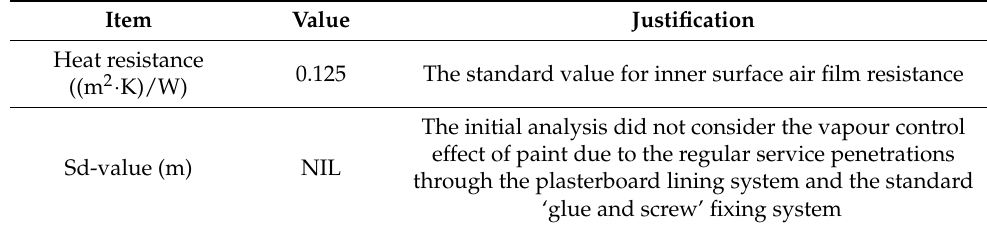
Table 8. User-defined settings of the interior